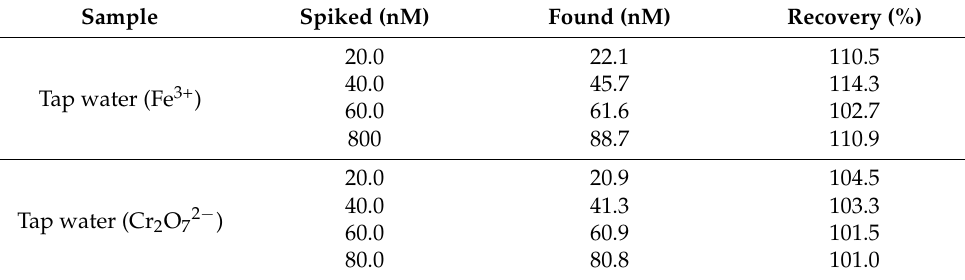
Table 3. Determination of Fe 3+ and Cr 2 O 72 − in real samples ( n =